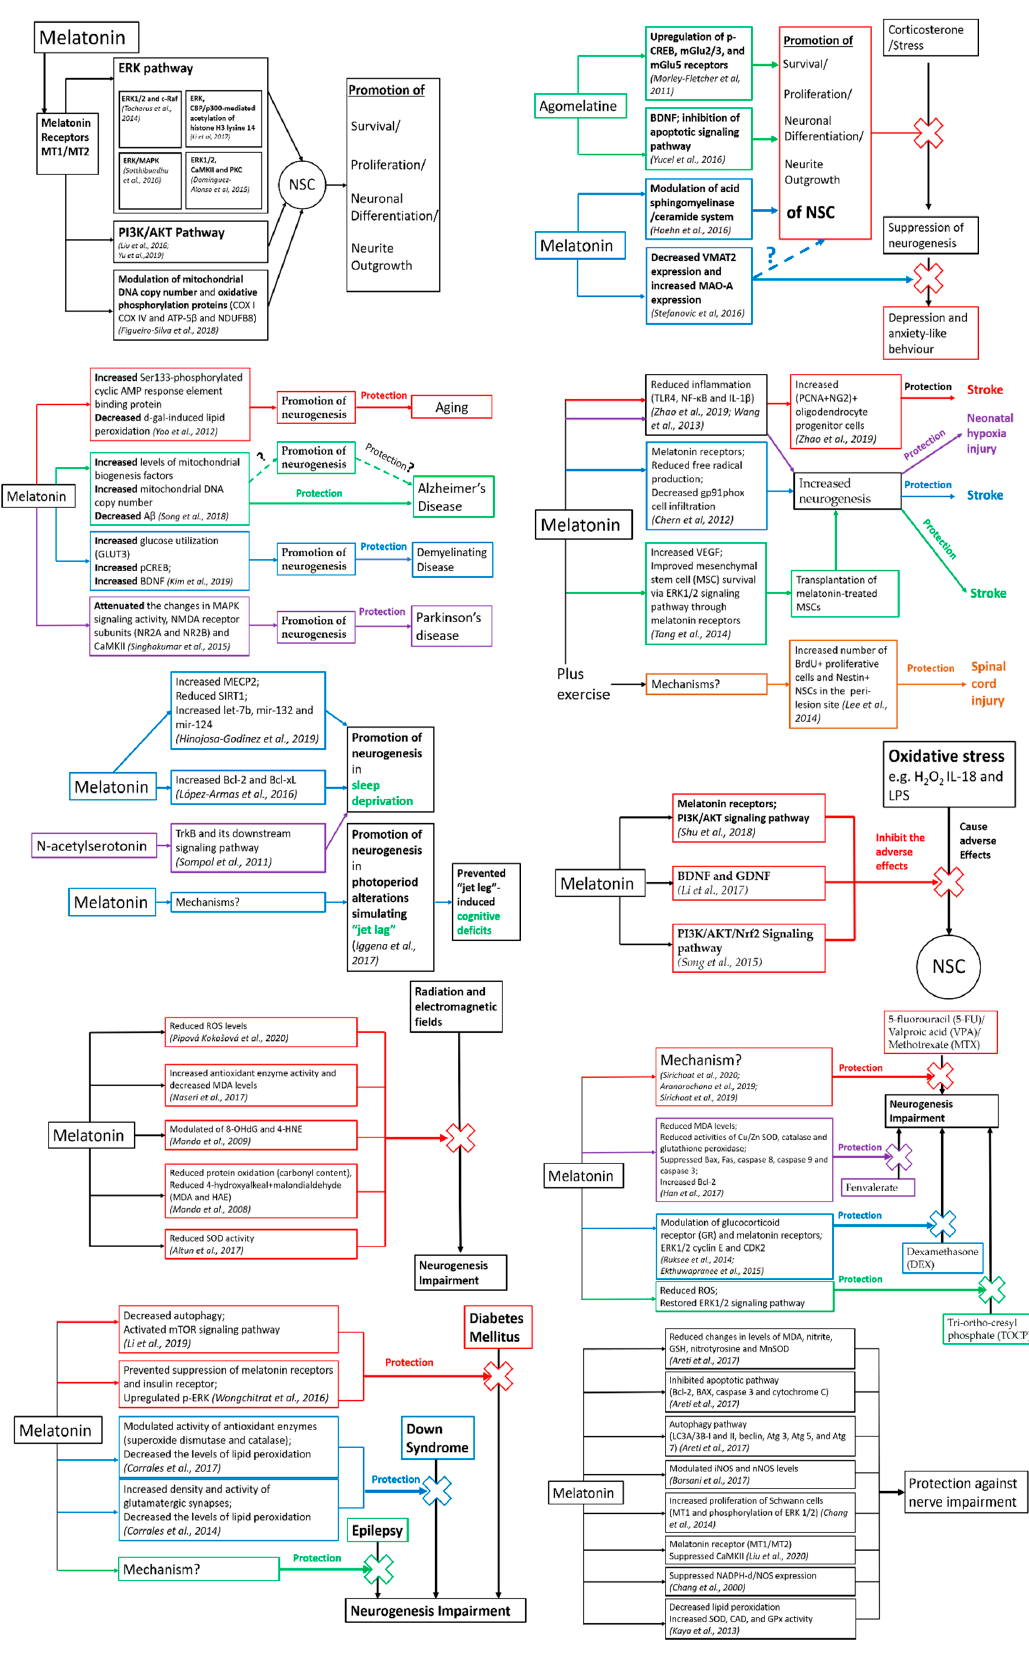
Figure 1. E ff ects of melatonin and its receptor agonist / precursor on neurogenesis and nerve regeneration and the respective molecular mechanisms in di ff erent neuropathological